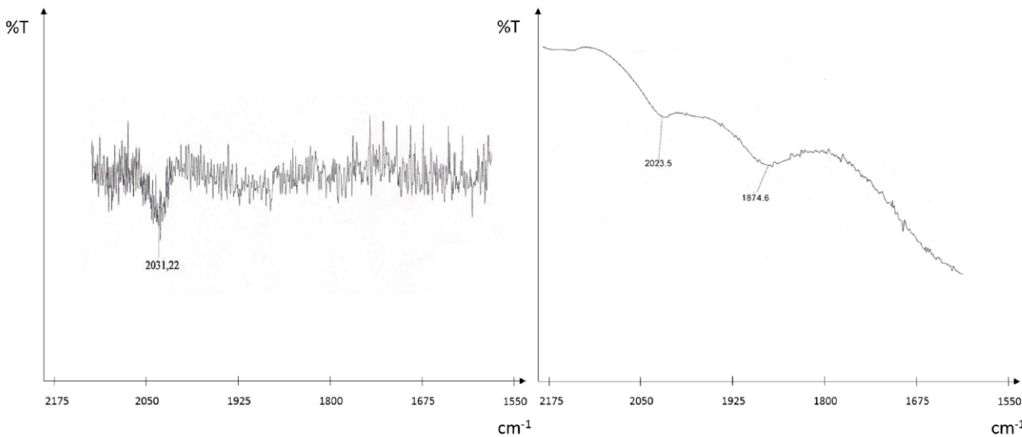
Figure 4. Solid-state IR spectra of the Rh-deposited CZOm ( left ) and ZOm ( right ) supports after treatment under N 2 at 500 °C.